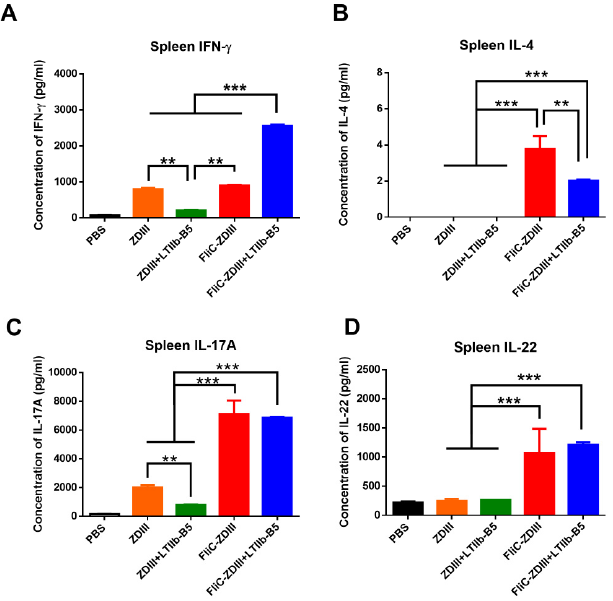
Figure 3. ZDIII ‐ specific T cell responses detected in spleen. ( A ) IFN ‐γ production in stimulated cells from the spleen; ( B ) IL ‐ 4 production in stimulated cells from the spleen; ( C ) IL ‐ 17A production in stimulated cells from the spleen; ( D ) IL ‐ 22 production in stimulated cells from the spleen. Statis ‐ tical test for multiple comparison for all groups except PBS were analyzed using one ‐ way ANOVA with Tukey’s or Holm ‐ Sidak’s multiple comparison tests. (**, p < 0.01 and ***, p < 0.001). Error bars are plotted as standard deviation from the mean value.